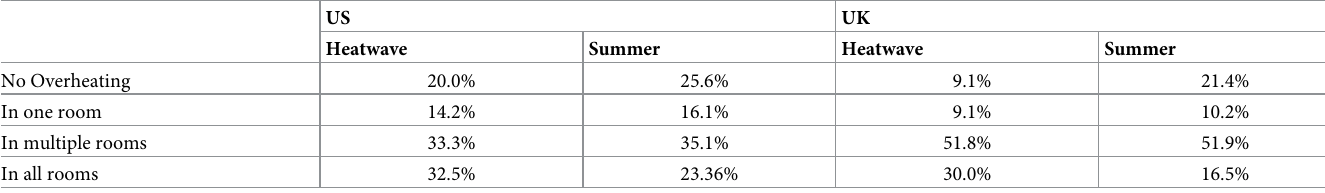
Table 6. Percentage of respondents reporting experiencing overheating during heatwaves and a normal summer in the US and the UK. US UK